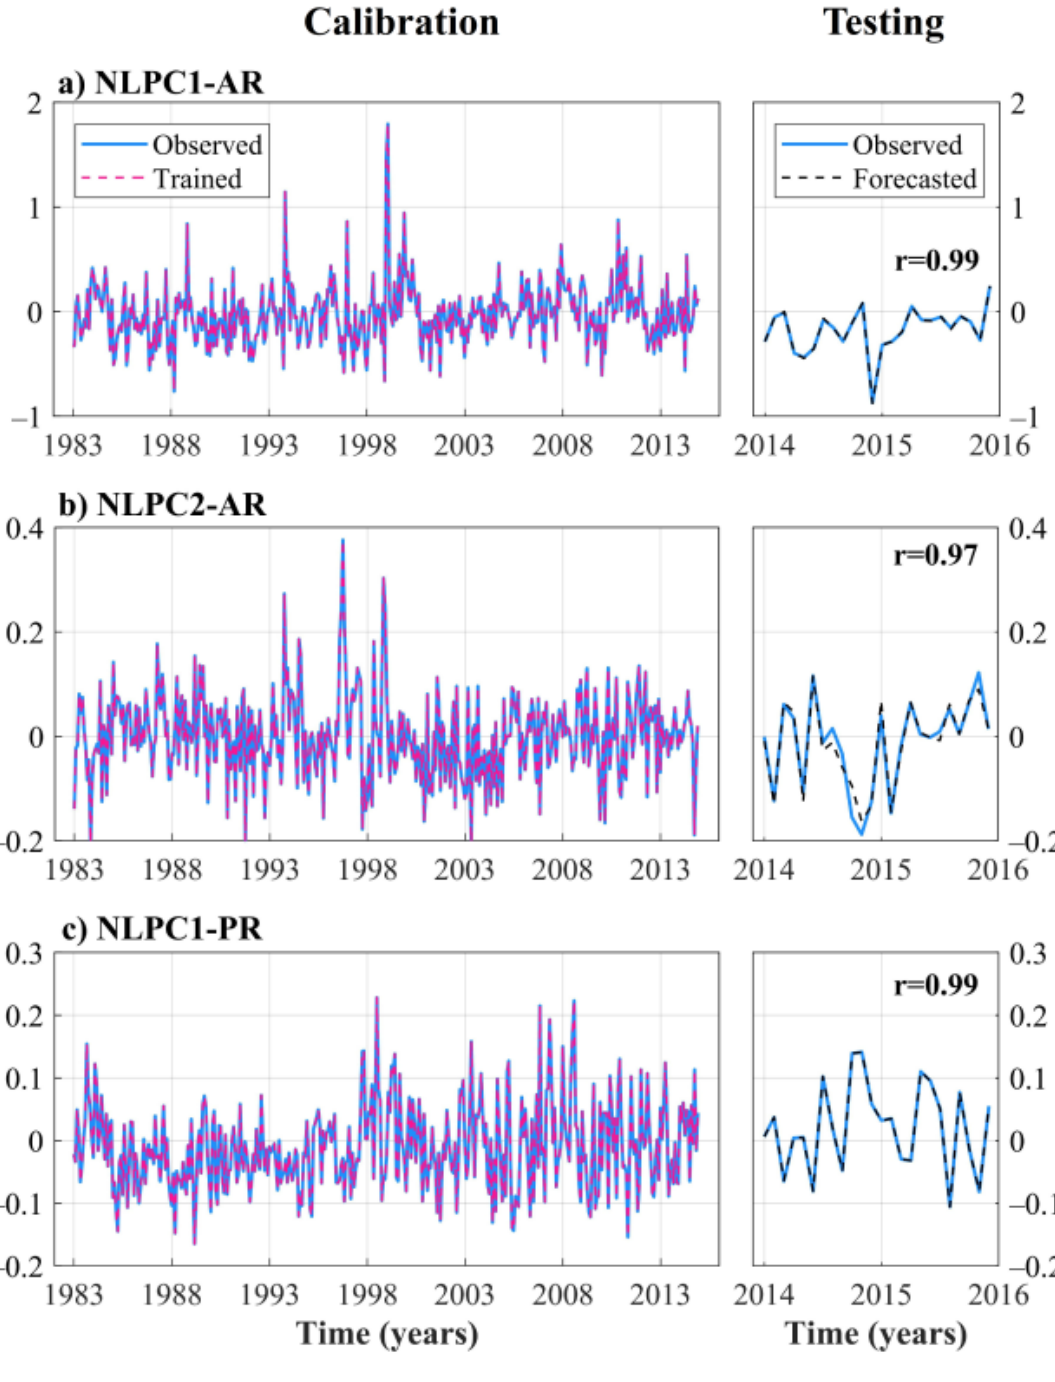
Figure 7. Results of the preliminary NNARMAX models for the calibration and testing period: ( a ) NLPC1-AR, ( b ) NLPC2-AR, and ( c ) NLPC1-PR.